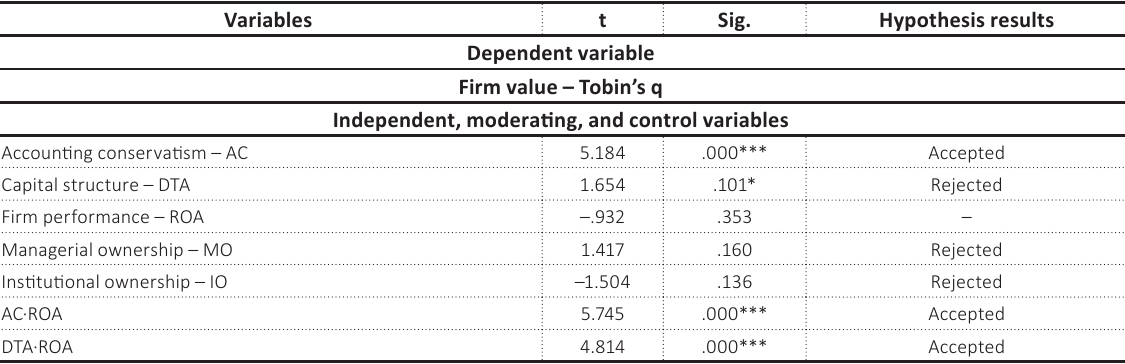
Table 3. Results of the regression